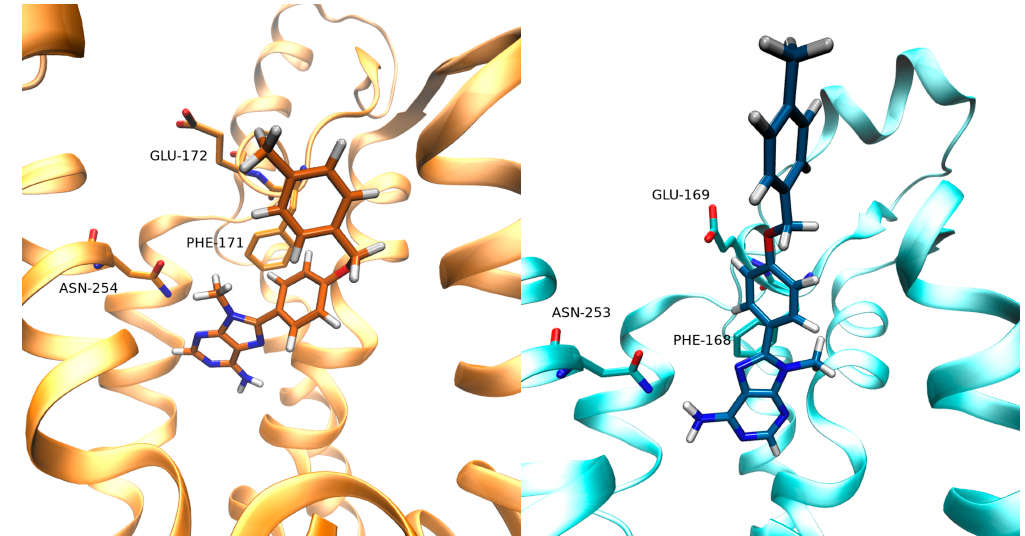
Figure 5. Binding mode of ligand LC4. A 1 AR on the left and A 2A AR on the right.